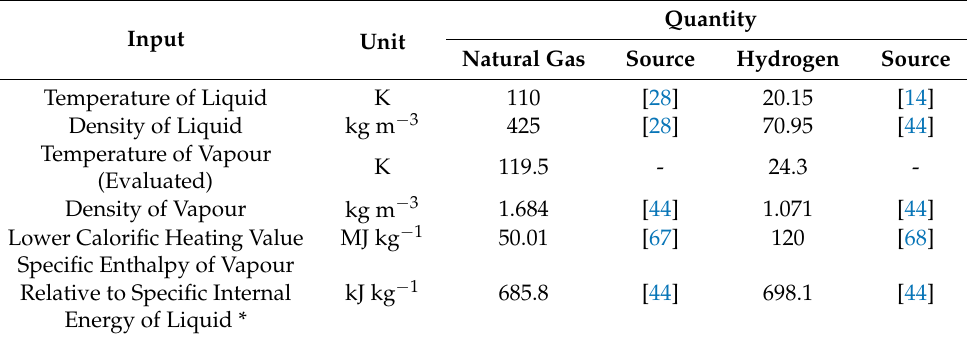
Table 5. LNG and LH2 properties at the design point [14,28,44,67,68].